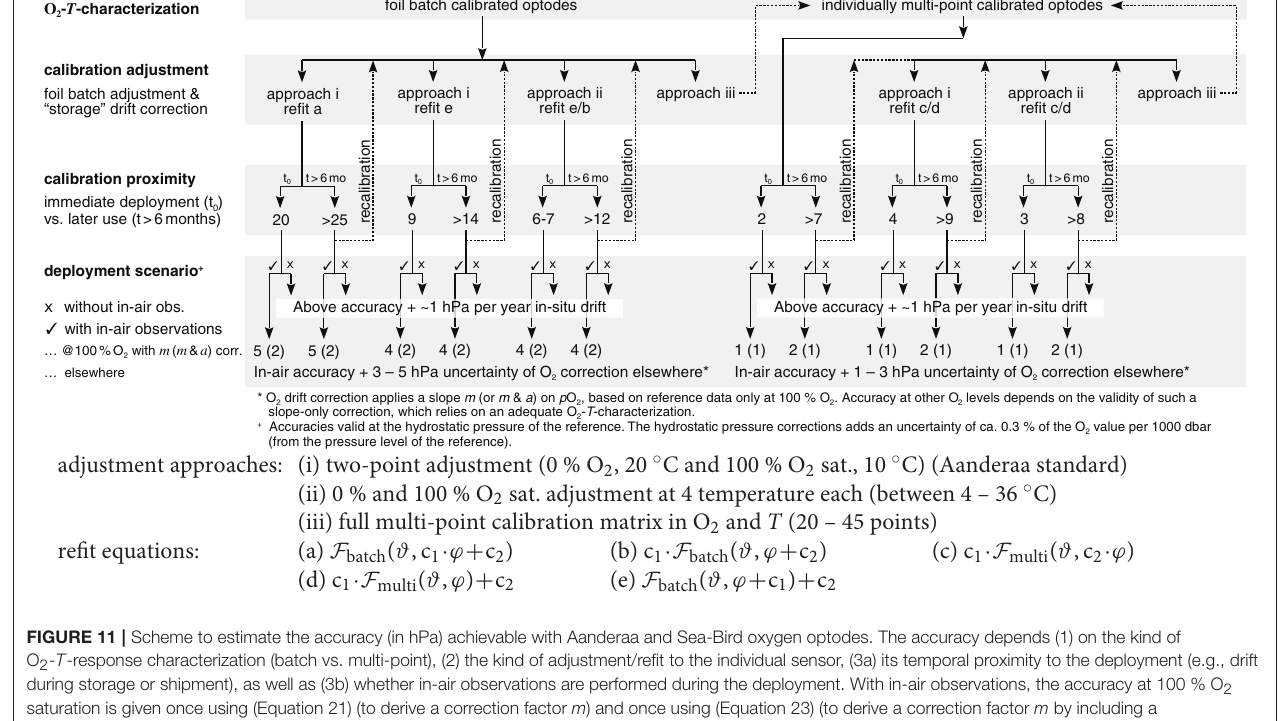
calibration adjustment foil batch adjustment & “storage” drift correction